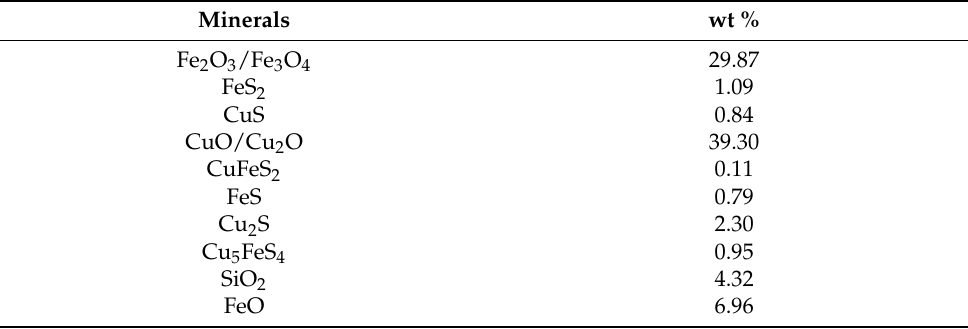
Table 4. Calcine of the sample Conc. A mineralogical